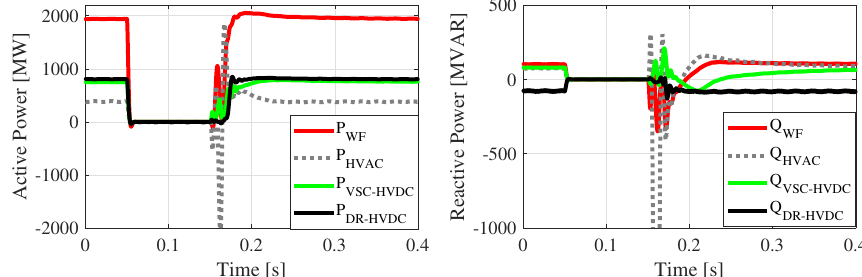
Figure 13. Active ( left ) and reactive ( right ) power of OWF and transmission lines when a three-phase short-circuit occurs in offshore